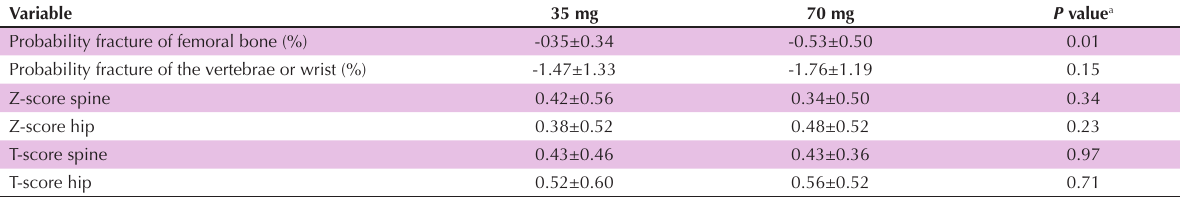
Table 3. Comparison of changes in mean fracture risk before and after intervention in two groups with 35 and 70 mg of alendronate Variable 35 mg Probability fracture of femoral bone